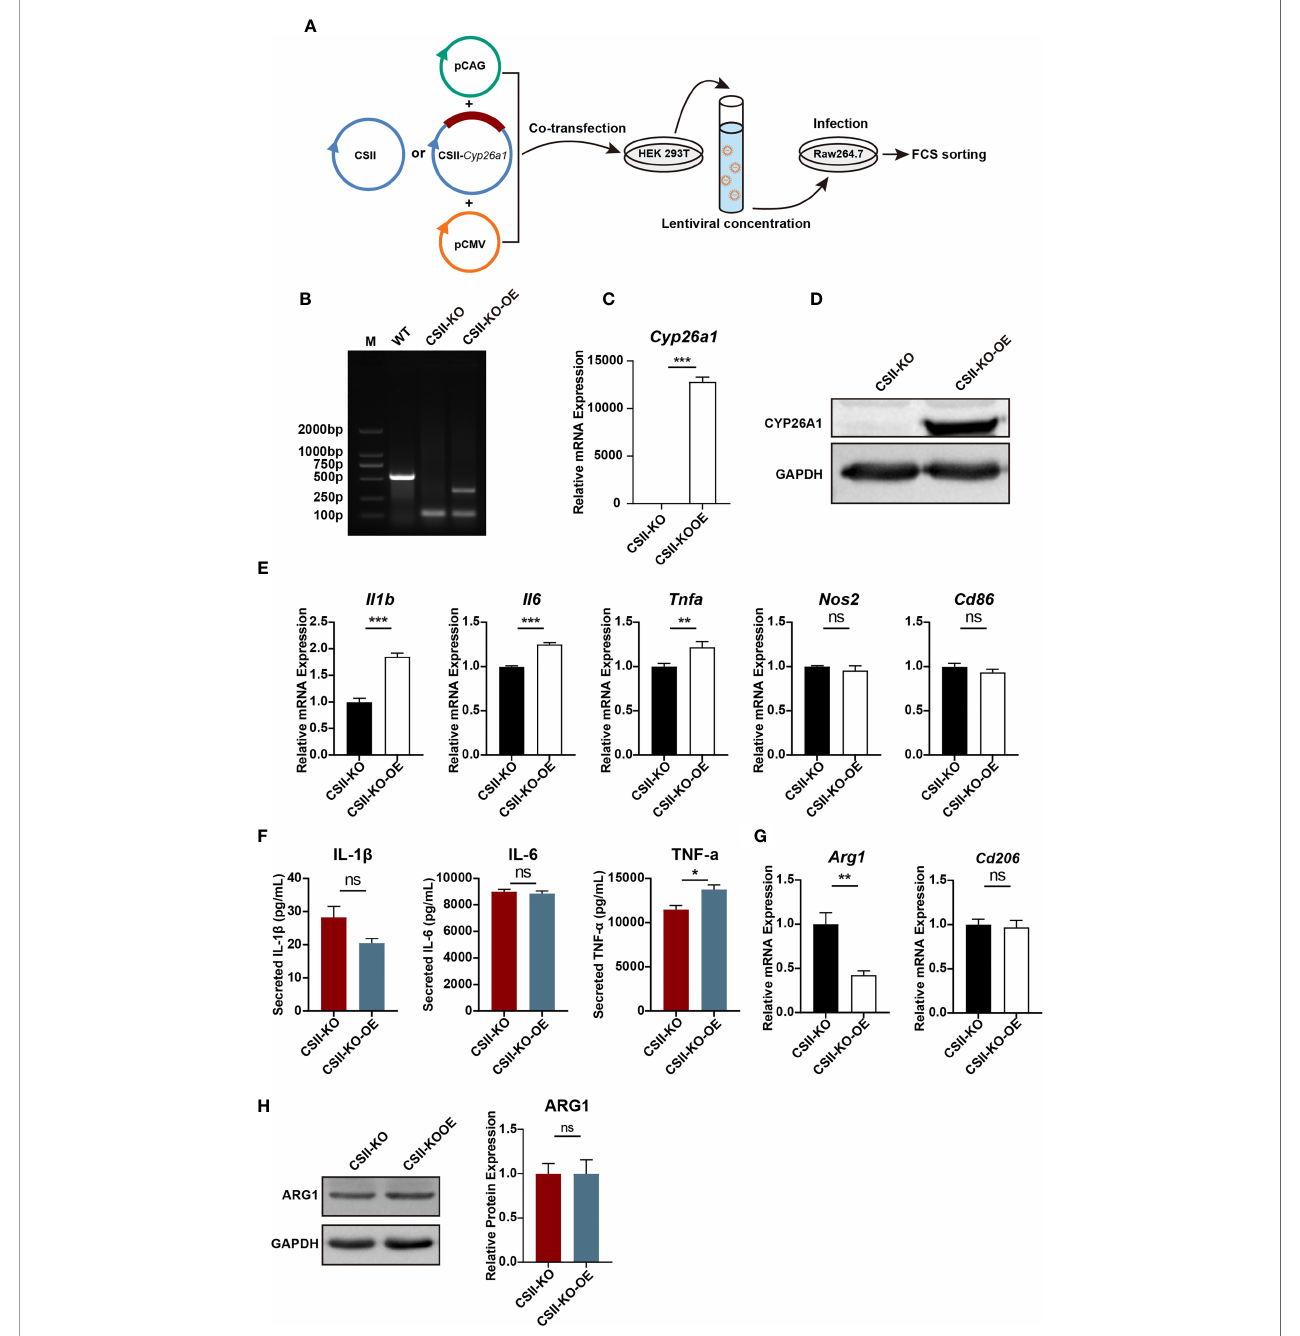
FIGURE 6 | Re-introduction of CYP26A1 partially reversed the polarization levels of M1 in CYP26A1 − / − Raw264.7 cells. (A) Schematic diagram of CYP26A1 overexpression in CYP26A1 − / − Raw264.7 cells with the lentiviral expression vector. (B – D) Genomic PCR, qPCR and Western blot were used to identify CYP26A1 overexpression cells. PCR products, WT: 526bp; KO: 99bp; KO-OE: 99bp, 334bp. (E) qPCR analysis of M1 phenotype genes Il1b , Il6 , Tnfa , Nos2 and Cd86 in CSII-KO and CSII-KO-OE cells after induced 4 h by LPS and IFN- g (n=3). (F) ELISA was used to measure IL-1 b , IL-6 and TNF- a secretion in supernatants of Raw264.7 cells (CSII-KO and CSII-KO-OE) treated with LPS and IFN- g for 24 h (n=3). (G) qPCR analysis of M2 markers Arg1 and Cd206 in Raw264.7 cells (CSII-KO and CSII-KO-OE) after induced 4 h by IL-4 and IL-13 (n=3). (H) Western blot analysis of M2 markers ARG1 in CSII-KO and CSII-KO-OE cells after induced 24 h by IL-4 and IL-13 (n=3). GAPDH was used as loading control. Error bars represent means ± SEM; two-tailed unpaired t-test, ns, not signi fi cant, *P < 0.05, **P < 0.01, or ***P <